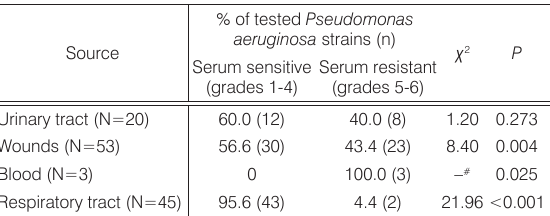
Table 5. Serum-Resistance of Pseudomonas aeruginosa Strains Recovered From Various